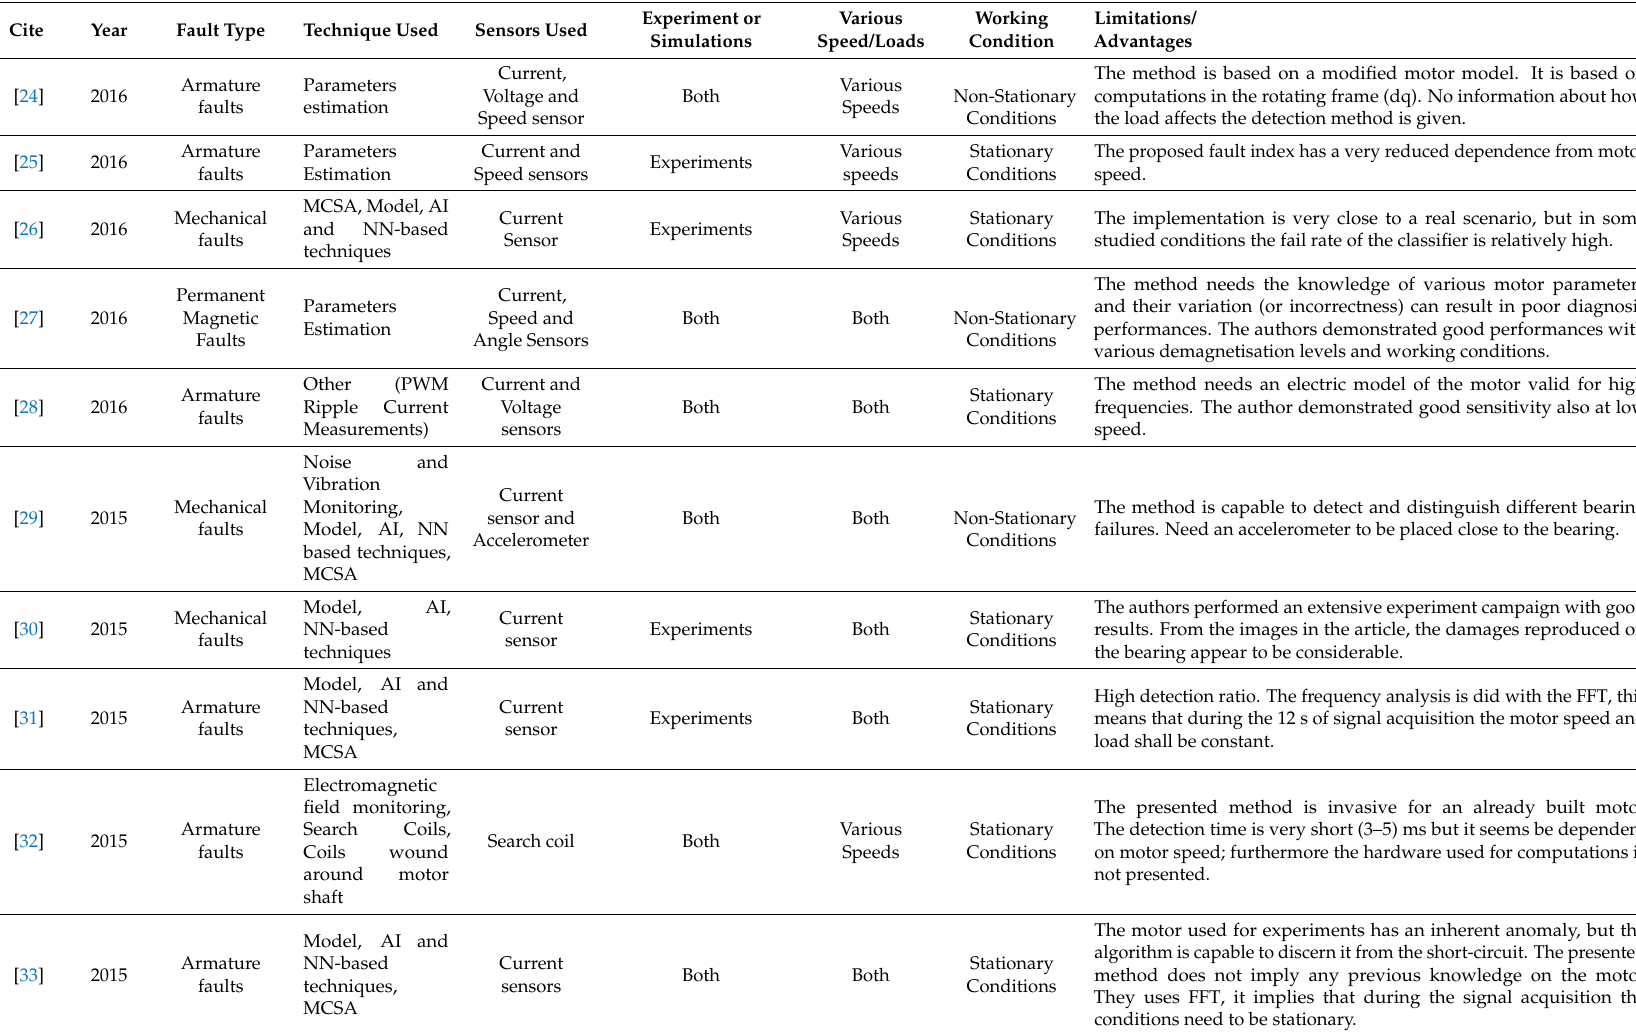
Table 3. Features table